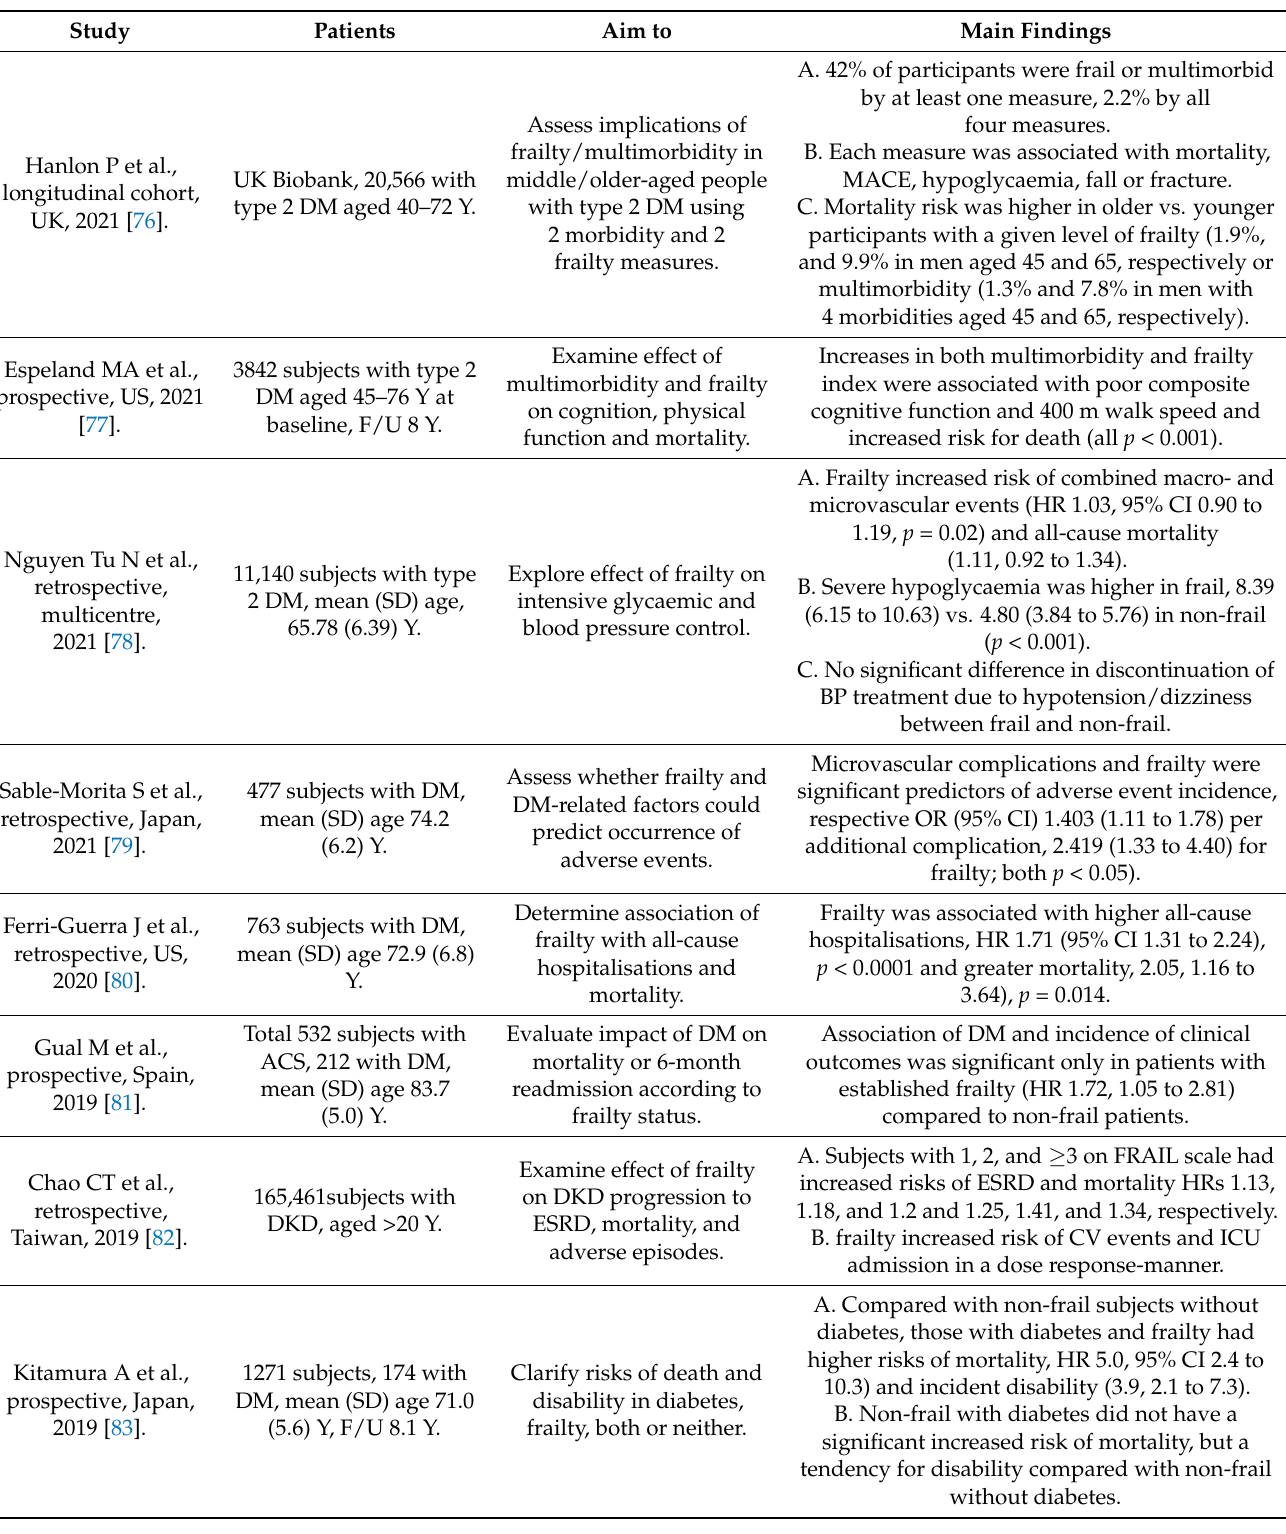
Table 3. Recent studies exploring effects of frailty on outcomes in older people with